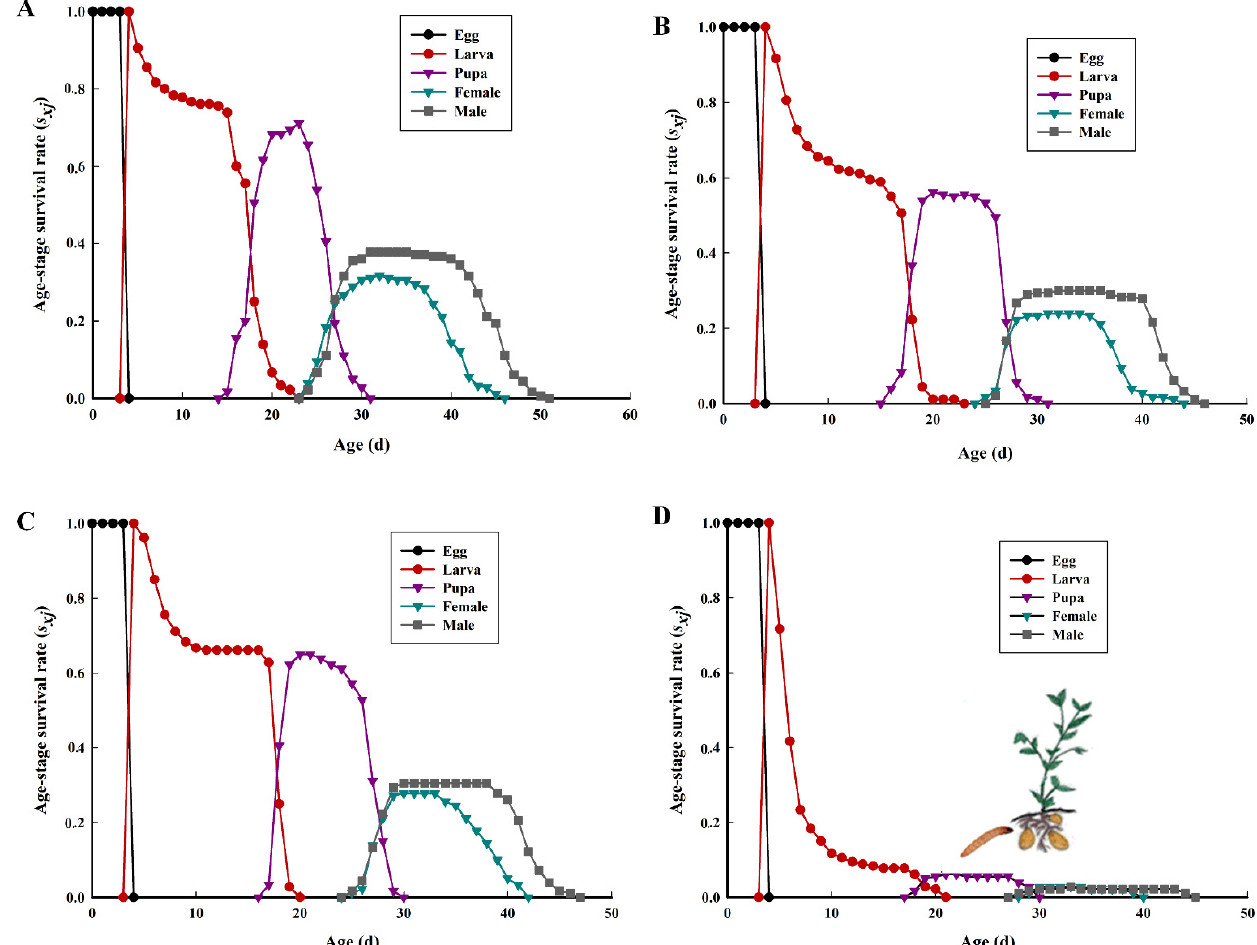
Figure 1. Age-stage specific survival rates (s xj ) of P. operculella on four different potato tuber varieties. ( A ): Lishu 6; ( B ): Hezuo 88; ( C ): Yunshu 304; ( D ): Qingshu 9.